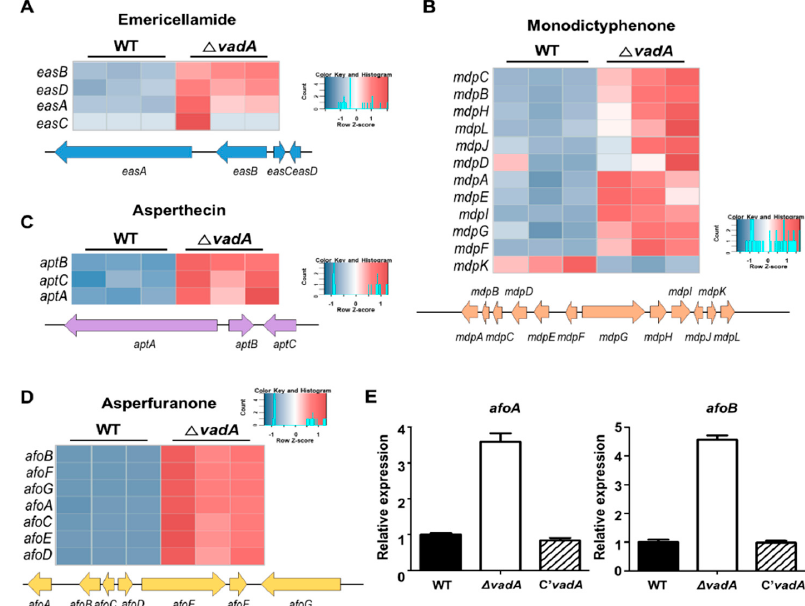
Figure 6. Expression of secondary metabolite gene clusters in Δ vadA conidia. ( A – D ) Heat map diagram of genes related to emericellamide ( A ), monodictyphenone ( B ), asperthecin ( C ), and asperfuranone ( D ) gene clusters. ( E ) mRNA expression of afoA and afoB in control (THS30), Δ vadA (THS33), and C’ vadA (THS34) conidia were assessed by qRT-PCR.